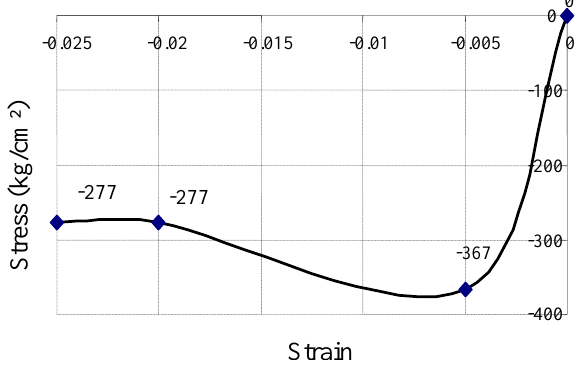
Fig. 10. Confined concrete constitutive relationships (core).